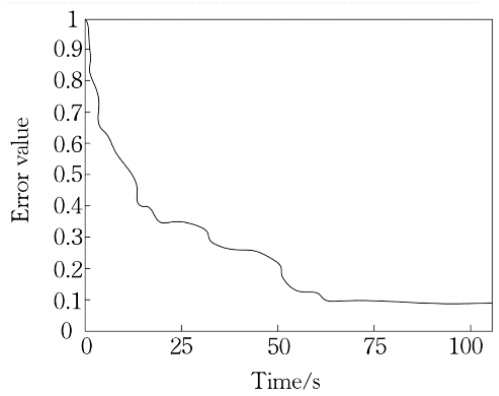
Figure 13. Error variation in convergence process.